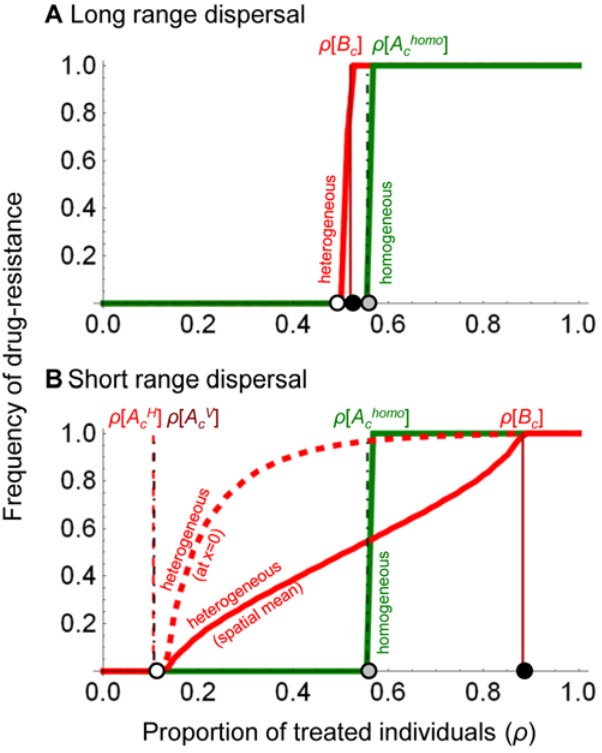
Figure 3. Comparison between homogeneous and heteroge- neous treatments. This figure represents the frequency of drug- resistance at equilibrium, as a function of the proportion of treated individuals ( r ~ A = A z B ð Þ ), for the homogeneous (green) and hetero- geneous (red) treatment strategies, with the vector-borne transmission model. The migration range is high in (a), and low in (b). The curves result from numerical integrations of the model, and the vertical lines show the analytical predictions; r X c ½ (cid:1) means ‘‘proportion of treated individuals corresponding to the critical size X c ’’. The red full curve shows the (spatial) mean frequency of drug-resistance, while the dashed red curve shows this frequency at the center of the treated area ~ 5 , b U ~ 5 : 1 , b ~ 5 : 05 , ( x ~ 0 ). Parameters: N H ~ 1 , N V ~ 10 , b T R WT WT b